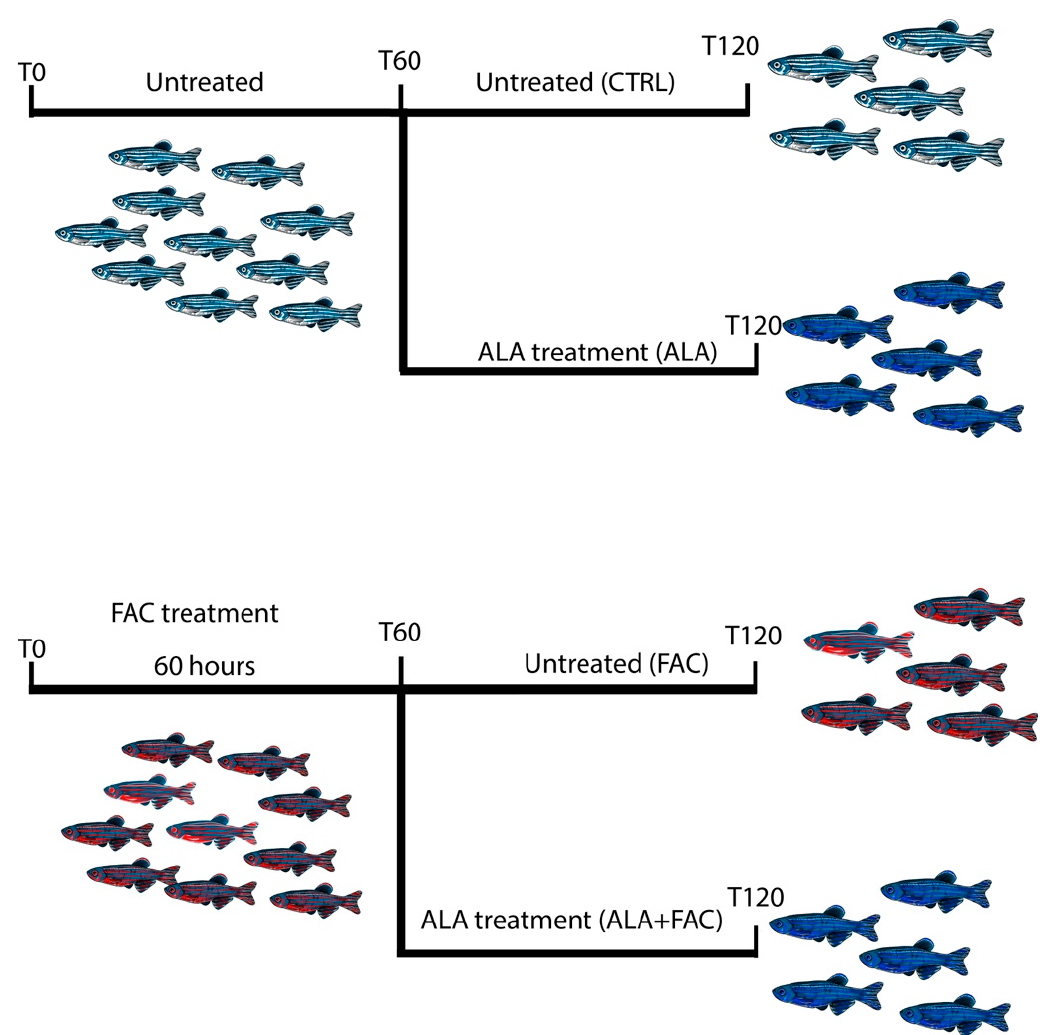
Figure 5. Schematic representation of the experimental design of zebrafish model of iron overload and ALA treatment.